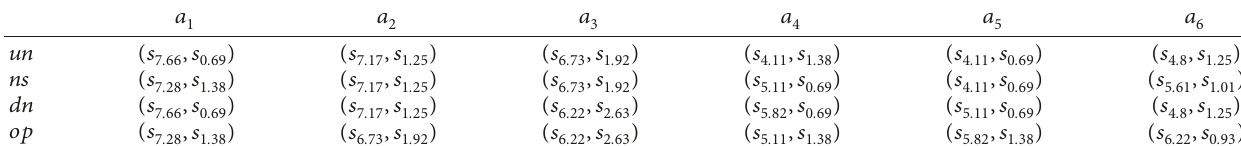
Table 7. Step 4. The relative priority of each alternative is calculated by using equation (69) and is shown in Table 8. Step 5. Rank the alternatives based on relative priority. The best alternative has greatest relative priority.